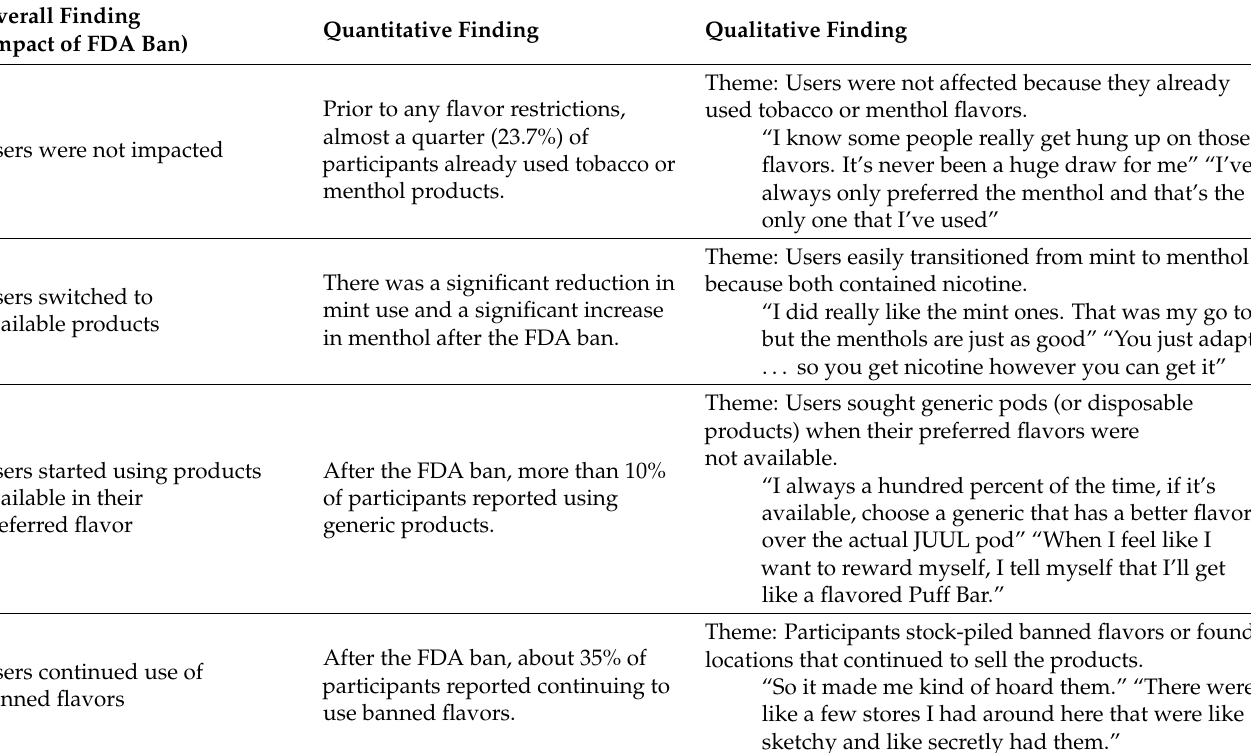
Table 3. Joint Display of Quantitative and Qualitative